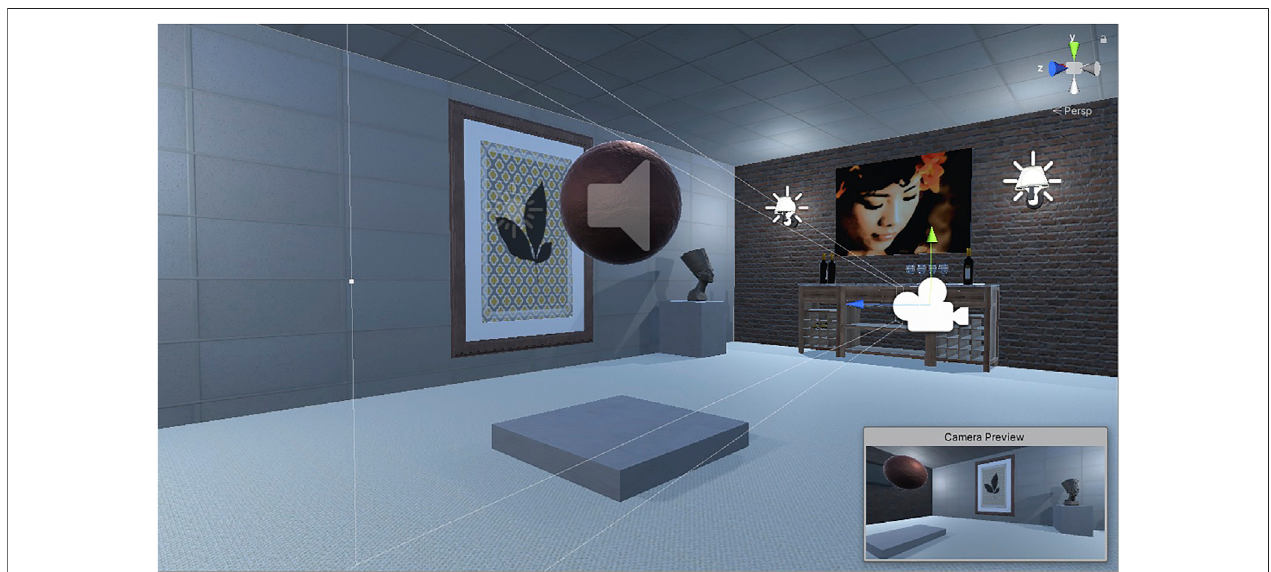
FIGURE 1 | The virtual environment from the scene viewer in the Unity gaming engine. The camera icon and camera preview show the perspectiveand FOV of the VR user upon launch. The speaker icon shows the audio source.